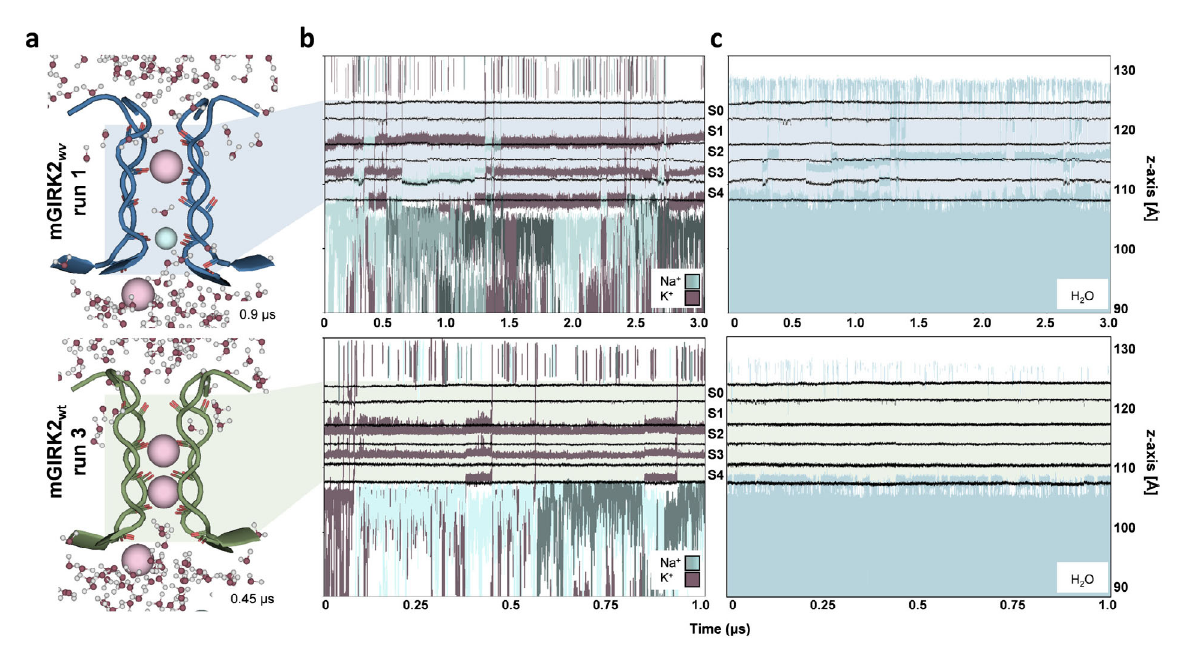
Fig. 2 Ion and water fl ux through the mGIRK2 wv (top) and mGIRK2 wt (bottom) SF over simulation time. a Representative snapshots of ion and water fl ux through the SF. mGIRK2 wv is colored blue, while mGIRK2 wt is colored green. The SF is depicted in cartoon representation with the backbone oxygens of the SF residues indicated as red sticks. K + ions are represented as pink spheres, while Na + ions are represented as smaller, light blue spheres. Water molecules are shown in a ball-and-stick representation. b K + (purple) and Na + ions (blue) fl ux observed in runs with mGIRK2 wv and mGIRK2 wt . Each line displays the position of one ion on the z -axis over simulation time. The positions of the backbone oxygens of the SF residues, which frame the canonical ion binding sites S0 – S4, are shown in black. c Presence of water in the mGIRK2 wv and mGIRK2 wt . Each line displays the position of one water molecule on the z -axis over simulation time. The positions of the backbone oxygens of the SF residues are shown in